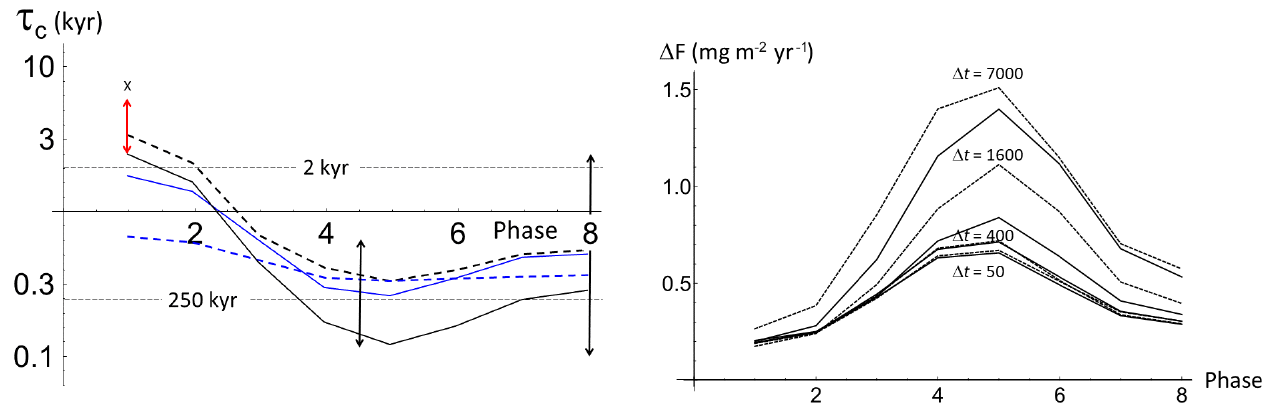
Figure 11. Using non-dimensional time, the amplitude of the Haar fluctuations are averaged over all the cycles The curves from bottom to top are for timescales of (cid:49)t = 50, 100, 200, 400, 800, 1600, 3500, and 7000years, alternating solid and dashed lines (for clarity, only some of the (cid:49)t ’s are marked). The cycle-to-cycle variability (the dispersion around each line) is about a factor of 2 (it is not shown to avoid clutter).